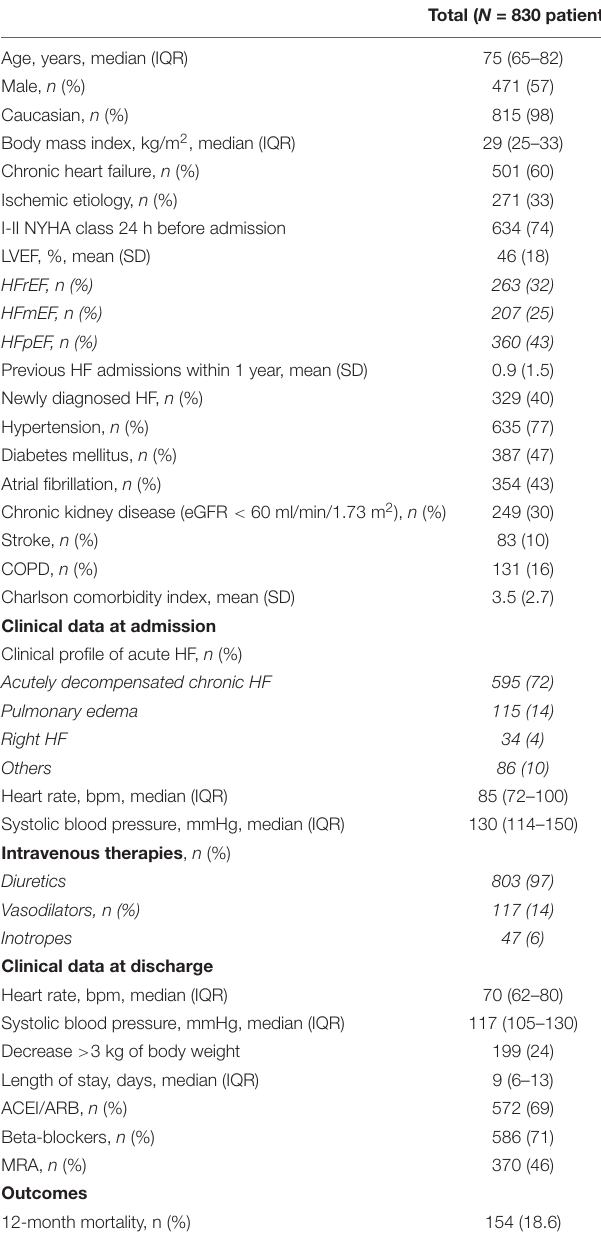
TABLE 1 | Baseline characteristics of the study